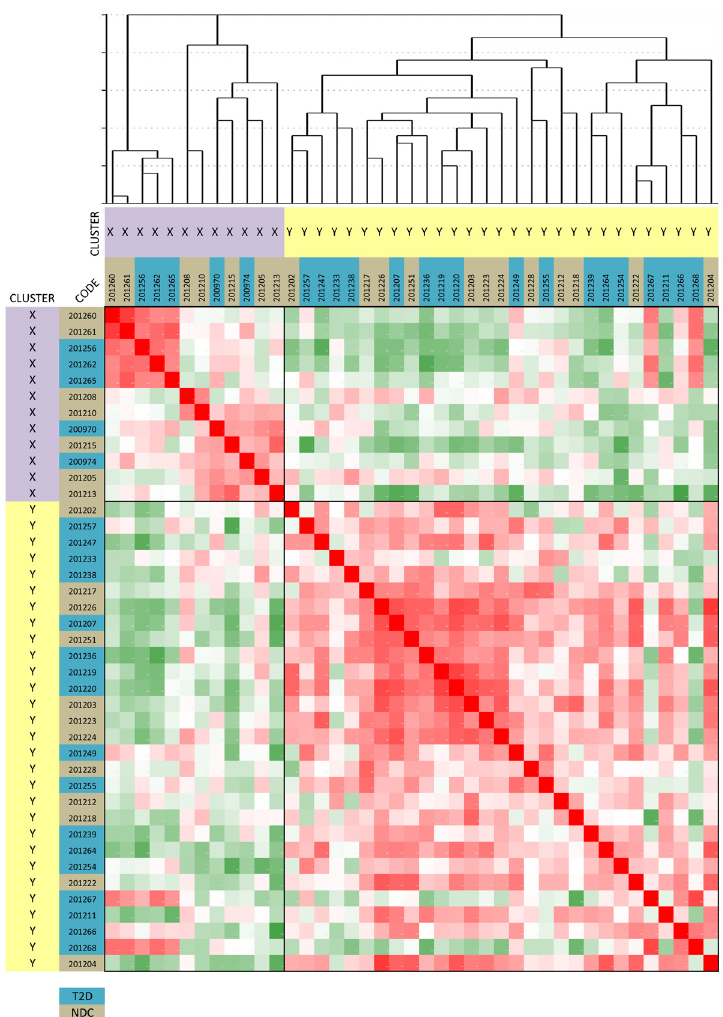
Fig 2. Dendrogram and heatmap of hierarchical clustering of T2D patients and non-diabetic controls of the validation cohort using microRNA and mRNA expression as determined by qPCR. This figure shows that two main subject clusters (X and Y) could be identified. Cluster X contained 5 diabetics and 7 non- diabetic subjects, and cluster Y comprised 17 diabetics and 12 non-diabetics. This approach did not distinguish between T2D patients and non-diabetic